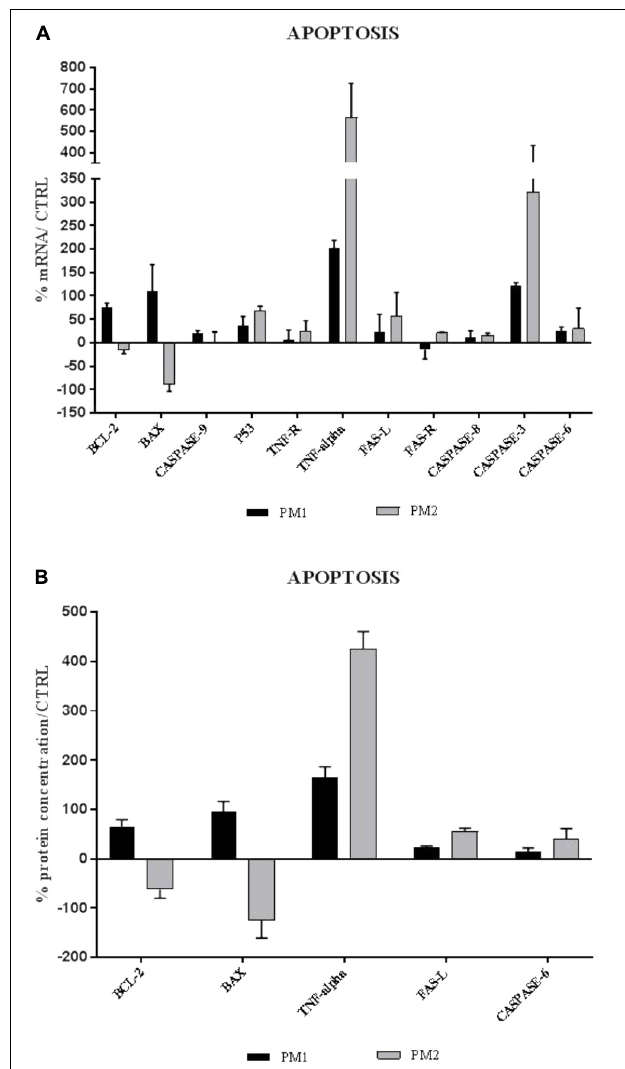
FIGURE 4 | Comparison between relative gene expression (A) and protein concentration (B) of apoptotic factors in PC3 cells with PM1 and PM2. Data are mean ± SD and are expressed as percentages of mRNA levels in each group compared to unstimulated cells